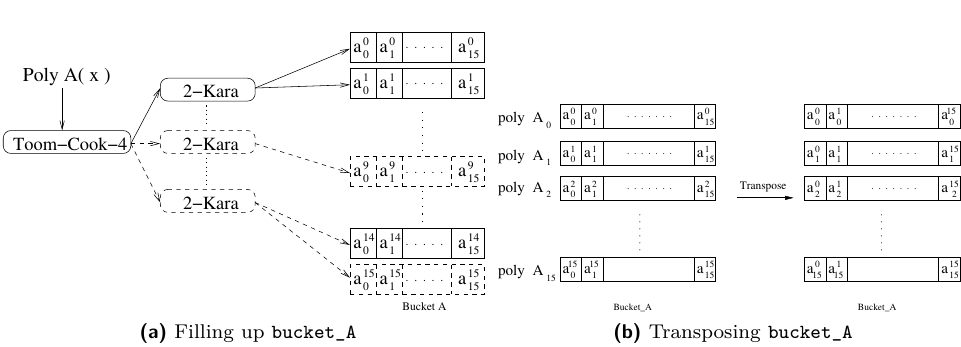
indicates j -th coefficient of i -th j